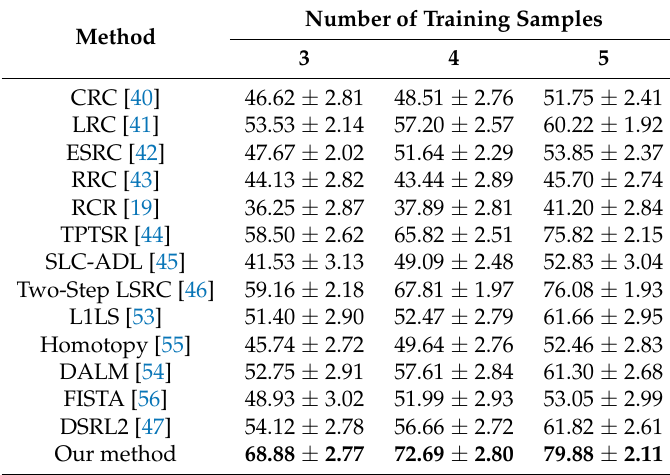
Table 3. Face recognition rates (%) of different methods on GT